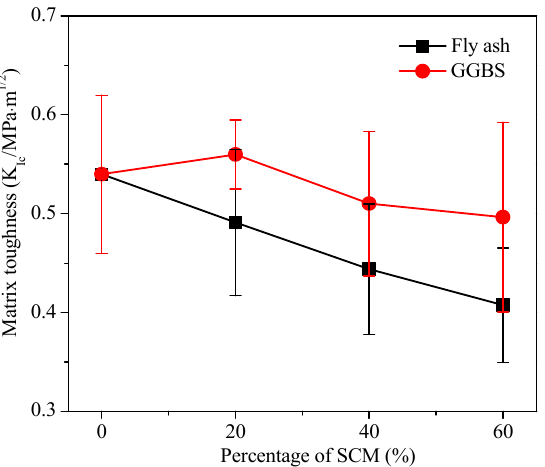
Figure 15. Matrix toughness of ULHS-ECCs as a function of dosage of SCM.